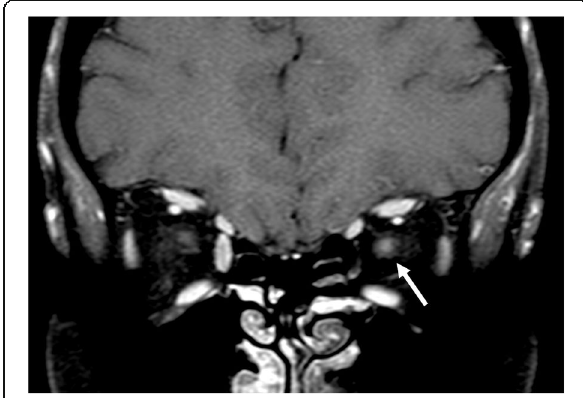
Fig. 24 Optic neuritis. MRI T1-weighted post gadolinium fat-saturated coronal image. Note the enlargement and the enhancement of the left optic nerve